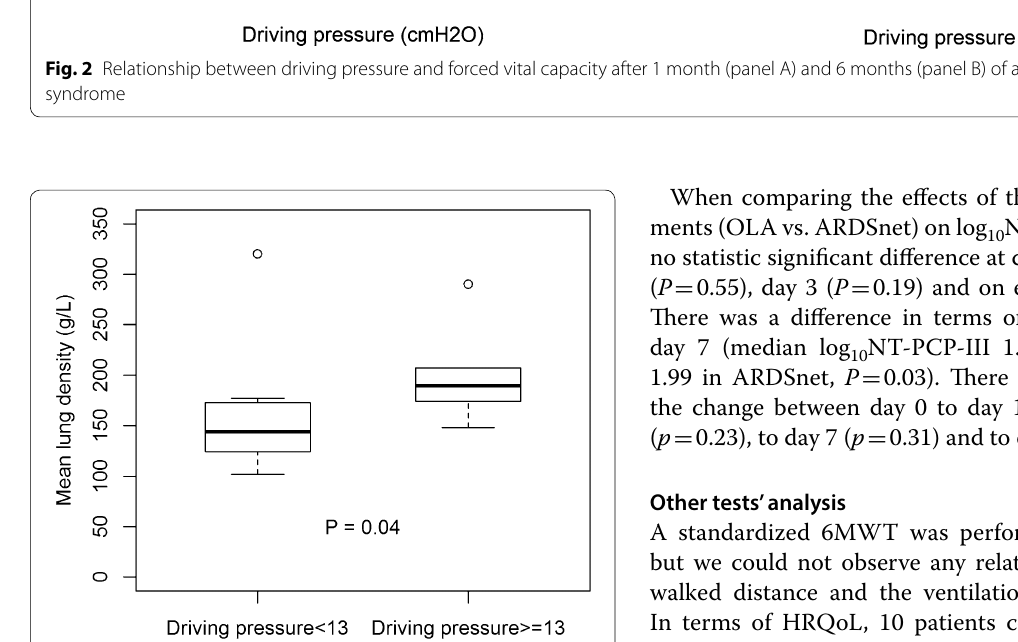
Fig. 3 Mean pulmonary parenchyma density in the whole-lung CT scan in 17 ARDS patients after 6 months of follow-up split based on driving pressure